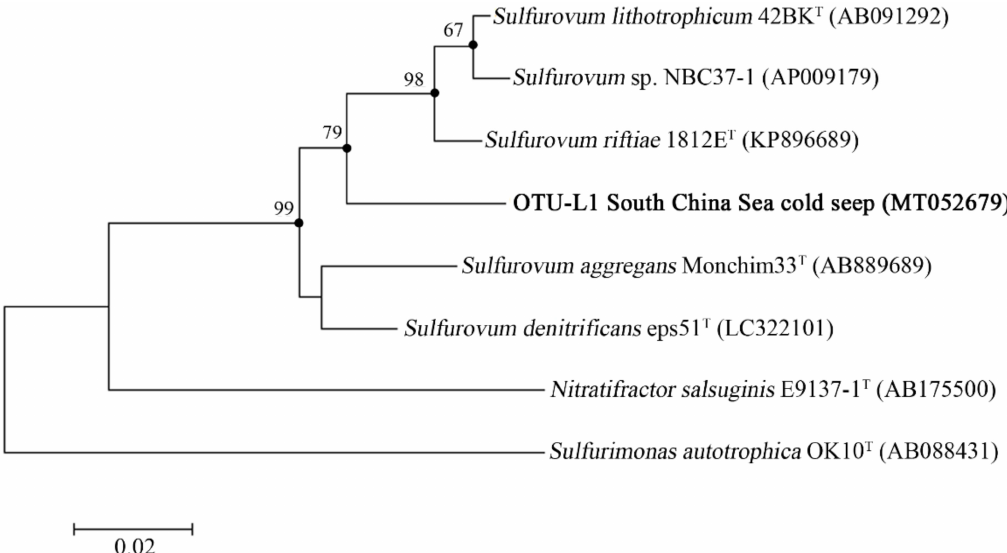
Figure 3. The maximum-likelihood phylogenetic tree based on nearly complete 16S rRNA gene sequences (1388 bp) showing the positions of operational taxonomic unit—L1 (OUT-L1) from this study, members of Sulfurovum , and representatives of some other related taxa. GenBank accession numbers are shown in parenthesis. Filled circles indicate that the corresponding nodes were also recovered in the trees generated with the neighbor-joining and maximum-parsimony algorithms. Only bootstrap values (expressed as percentages of 1000 replications) equal or greater than 50% are shown at the branching points. Sulfurimonas autotrophica OK10 T (GenBank accession number, AB088431) was used as an outgroup. Scale bar, 0.02 substitutions per nucleotide